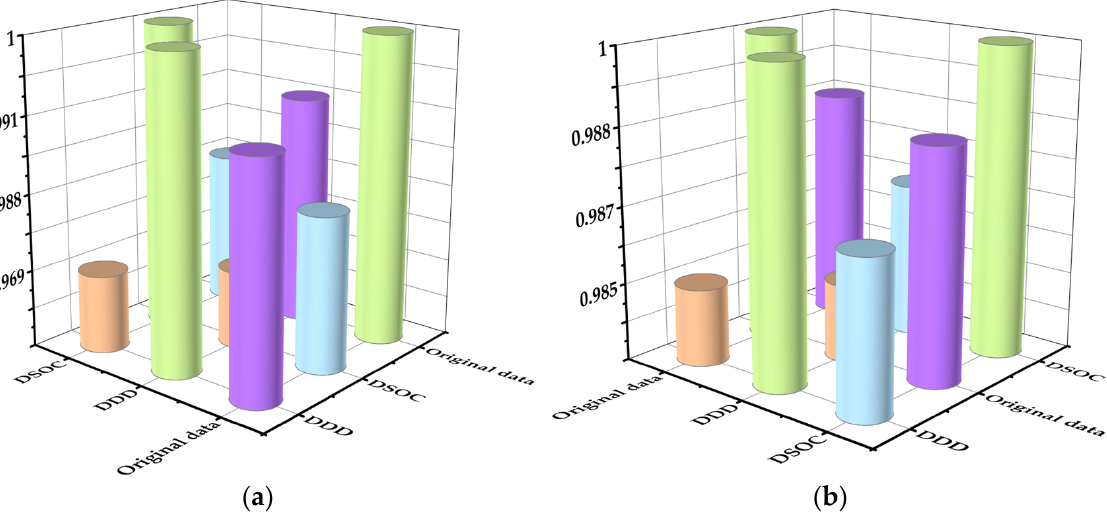
Figure 11. Correlation analysis of the three trends in ( a ) shell temperature and ( b ) bearing temper- ature.